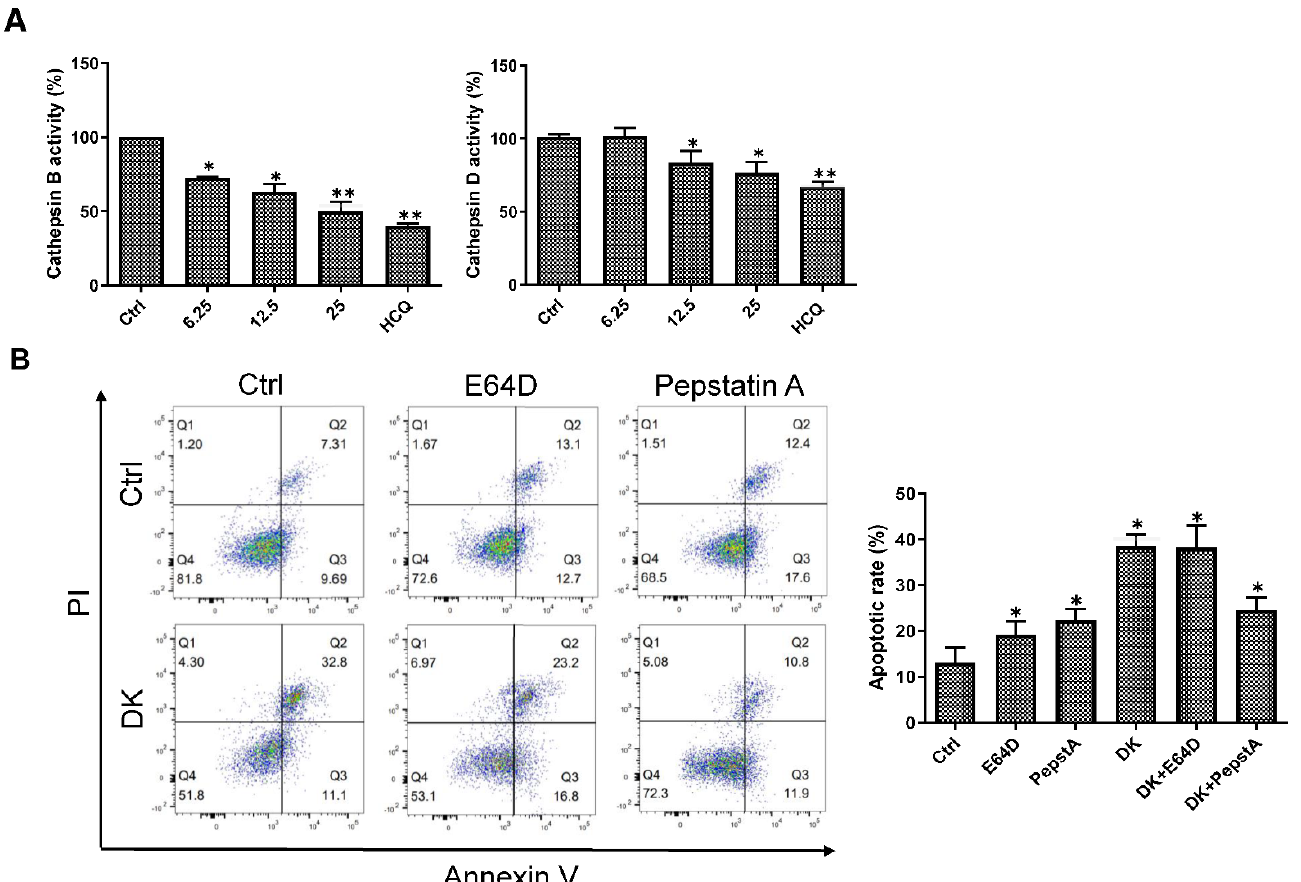
Figure 6. Dieckol (DK) inhibits cathepsins activity and pepstatin A, an inhibitor of cathepsin D (CTSD), restored DK-induced apoptosis. ( A ) A375 human melanoma cells were treated with various concentrations of DK or 15 µ M HCQ for 48 h and the cell lysates were collected. Enzyme activity of CTSB and CTSD was analyzed using fluorogenic kits. Results are quantified and shown as mean ± standard deviation (SD) of triplicate independent experiments. ( B ) Cells were treated with E64D (50 µ M) or pepstatin A (50 µ M) in the presence or absence of 25 µ M DK for 48 h. Apoptotic cells were analyzed by flow cytometry. Annexin V-positive cells were described as apoptotic cells. The quantified results are shown as mean ± standard deviation (SD) of triplicate independent experiments. ** p < 0.01, * p < 0.05 compared to the control.